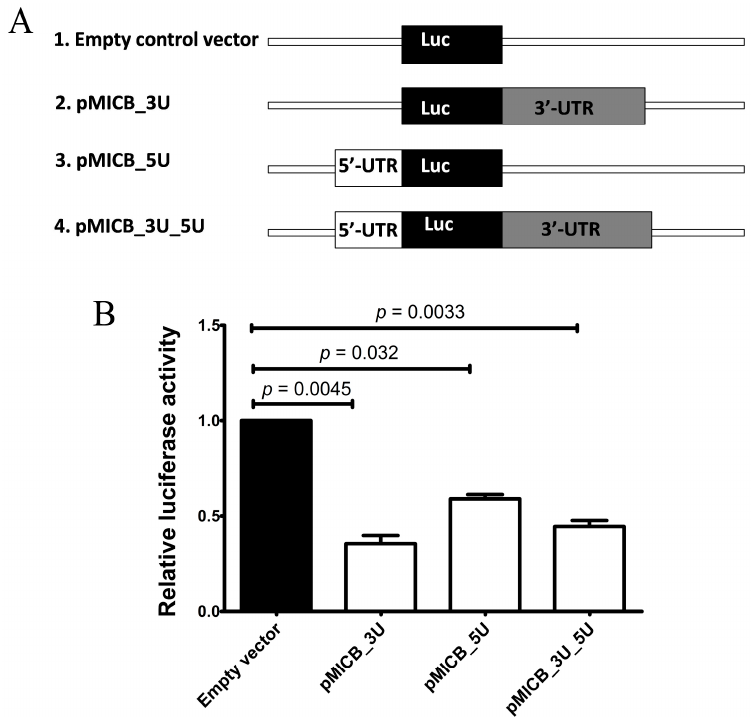
Figure 2 . The effect of 3’ - and 5’ - untranslated regions ( UTRs ) of MICB on luciferase activity. ( A ) The constructs used for transfection in these experiments are represented . Luciferase gene alone is an empty control vector . Plasmids containing3 ′ - UTR, 5 ′ - UTR and both 3 ′ - and 5 ′ - UTR inserts are abbreviated with pMICB_3U, pMICB_5U and pMICB_3U_5U, respectively; ( B ) Effect of 3 ′ - UTR and pMICB_3U, pMICB_5U and pMICB_3U_5U, respectively; ( B ) Effect of 3 (cid:48) -UTR and 5 (cid:48) -UTR of MICB 5 ′ - UTR of MICB on luciferase expression when these vectors were transfected to 239T cells are shown . Firefly luciferase activity was normalized with Renilla luciferase activity to give relative expression and subsequently normalized to the activity of control reporter . Results are depicted as mean ± S . E . M, n = 3 experiments .